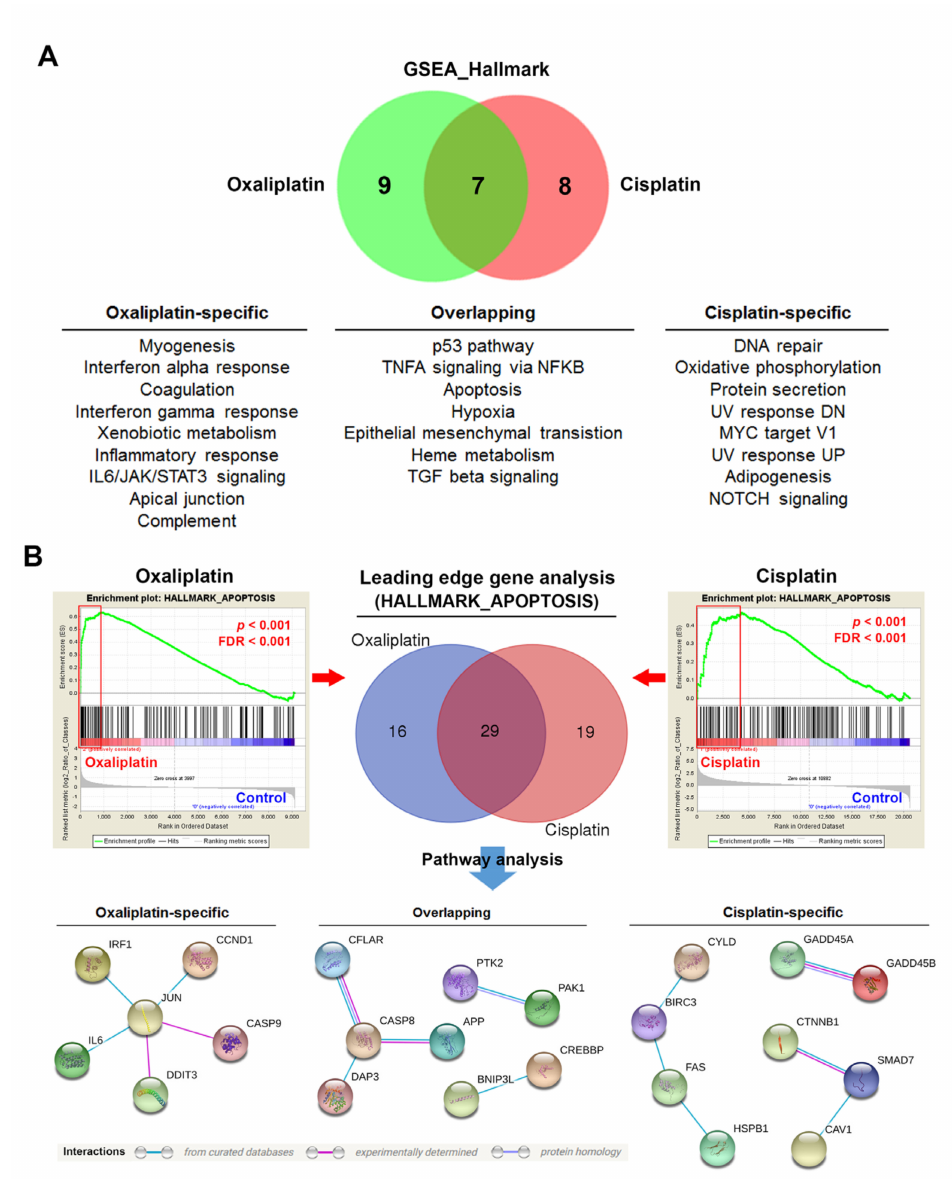
Figure 3. Gene set enrichment analysis (GSEA) for cisplatin- and oxaliplatin-treated A2870 cells. ( A ) The microarray data set for oxaliplatin- and cisplatin-treated A2780 human ovarian cancer cells (GSE8057) was obtained from the National Center for Biotechnology Information (NCBI) Gene Expression Omnibus (GEO) database. GSEA was performed for the enrichment of 50 cancer hallmarks. The enriched hallmarks with p < 0.01 and false discovery rate (FDR) with p < 0.25 are shown in the Venn diagram. ( B ) The enrichment plots for the apoptosis hallmark in oxaliplatin- and cisplatin-treated A2780 cells. The leading edge genes are highlighted in the red squares. The overlapping, oxaliplatin-specific, and cisplatin-specific genes were analyzed using the STRING database for network